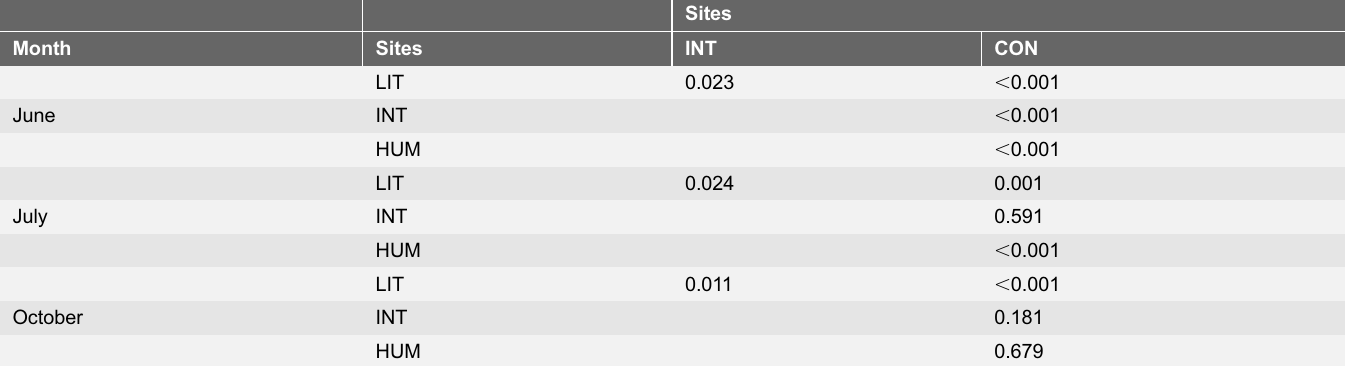
Table 1. The P values of the Mann–Whitney U Test of CO 2 flux among the four